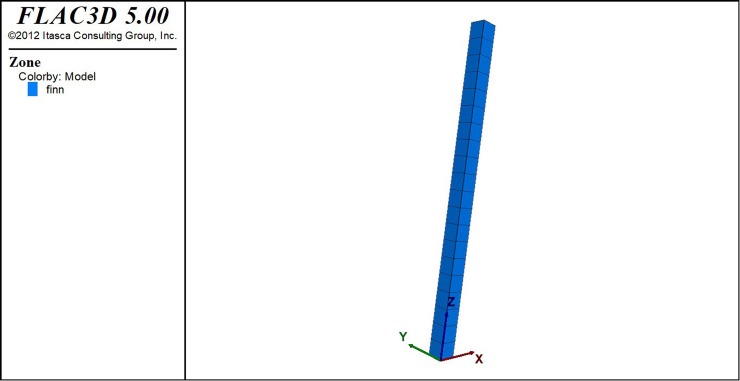
Geometry of the model designed for this study.